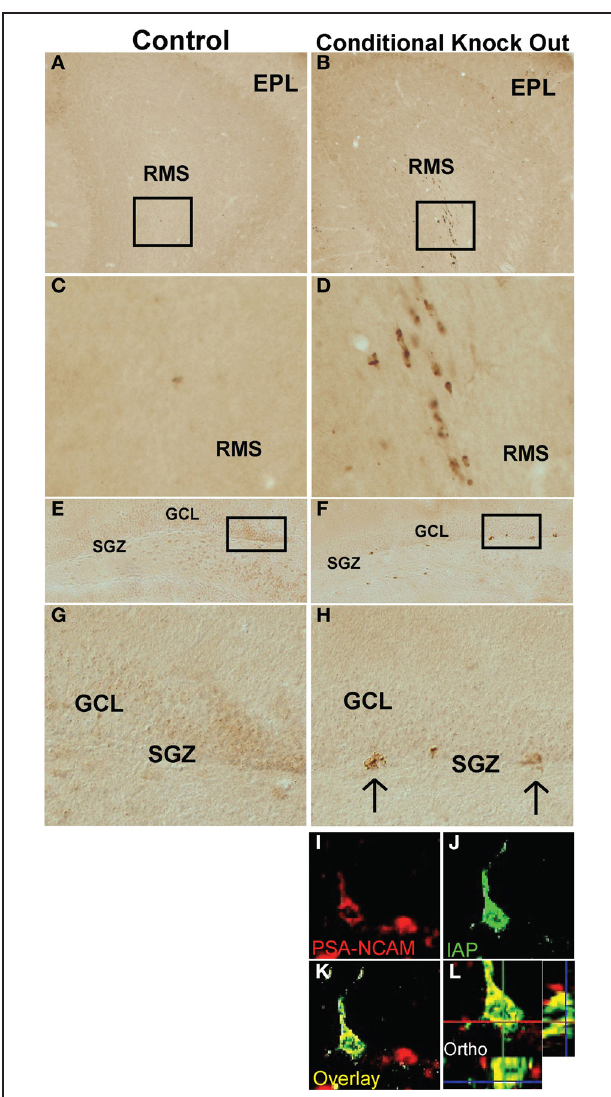
FIGURE 10 | Expression of PSA-NCAM and Doublecortin is depleted in the OB, rostral migratory stream (RMS), DG, and subgranular zone (SGZ) of DNMT1-cKO mice. Survey and detail of frontal sections through the OB (A–H) , RMS (I–P) , and DG (Q–X) stained with bright-field immunohistochemistry for PSA-NCAM (left panel) and Doublecortin (right panel). PSA-NCAM and Doublecortin labeled cells are rare in DNMT1-cKO mice as compared to age matched controls. Scale bars: D,I,T = 10mm; H,P,X = 1.25mm. of granule neurons in mature adults or in the numbers added to the OB or DG by PNN during juvenile development. It